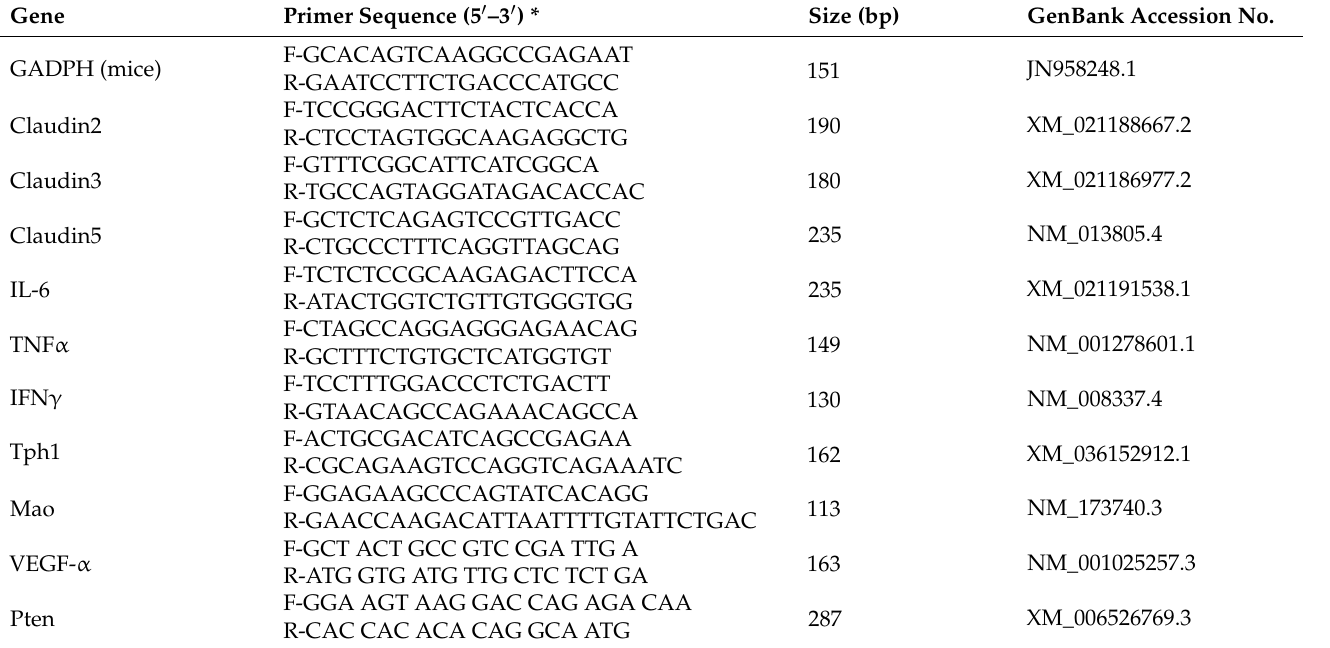
Table 2. List of primers used to analyze mice intestinal gene sequences used in RT-PCR